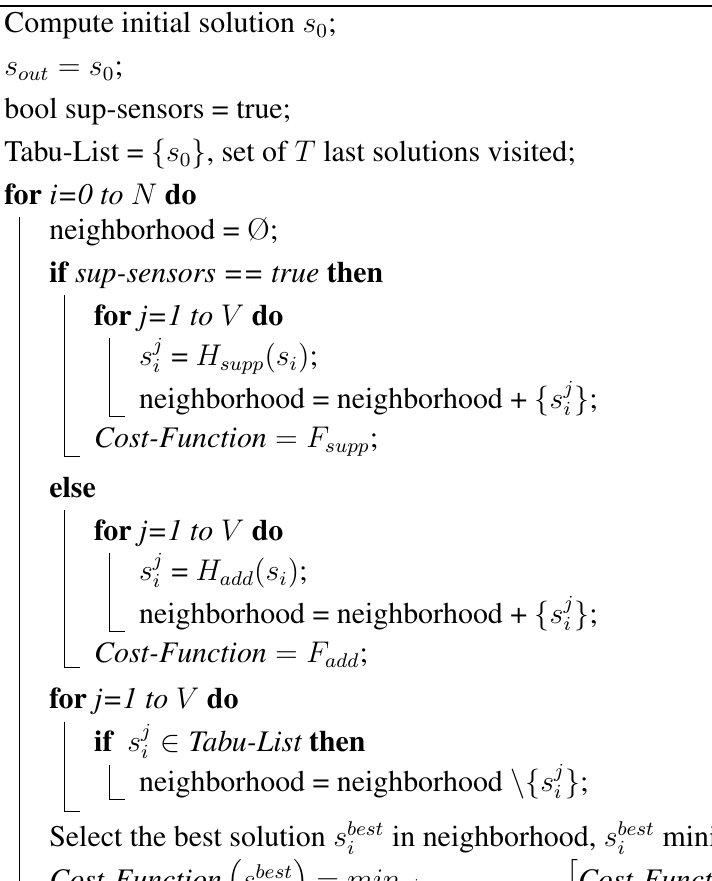
Algorithm 1 : Tabu search pseudo